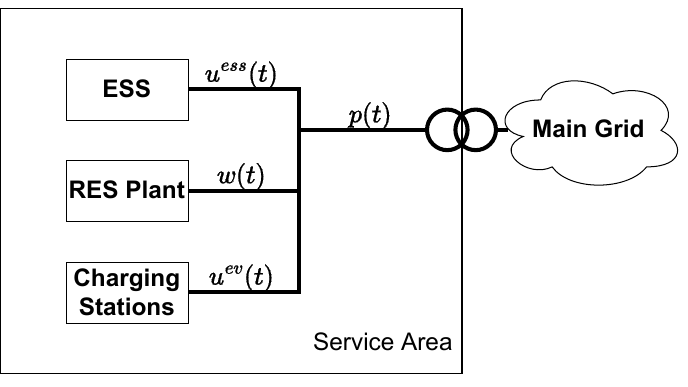
Figure 1. Setup of case